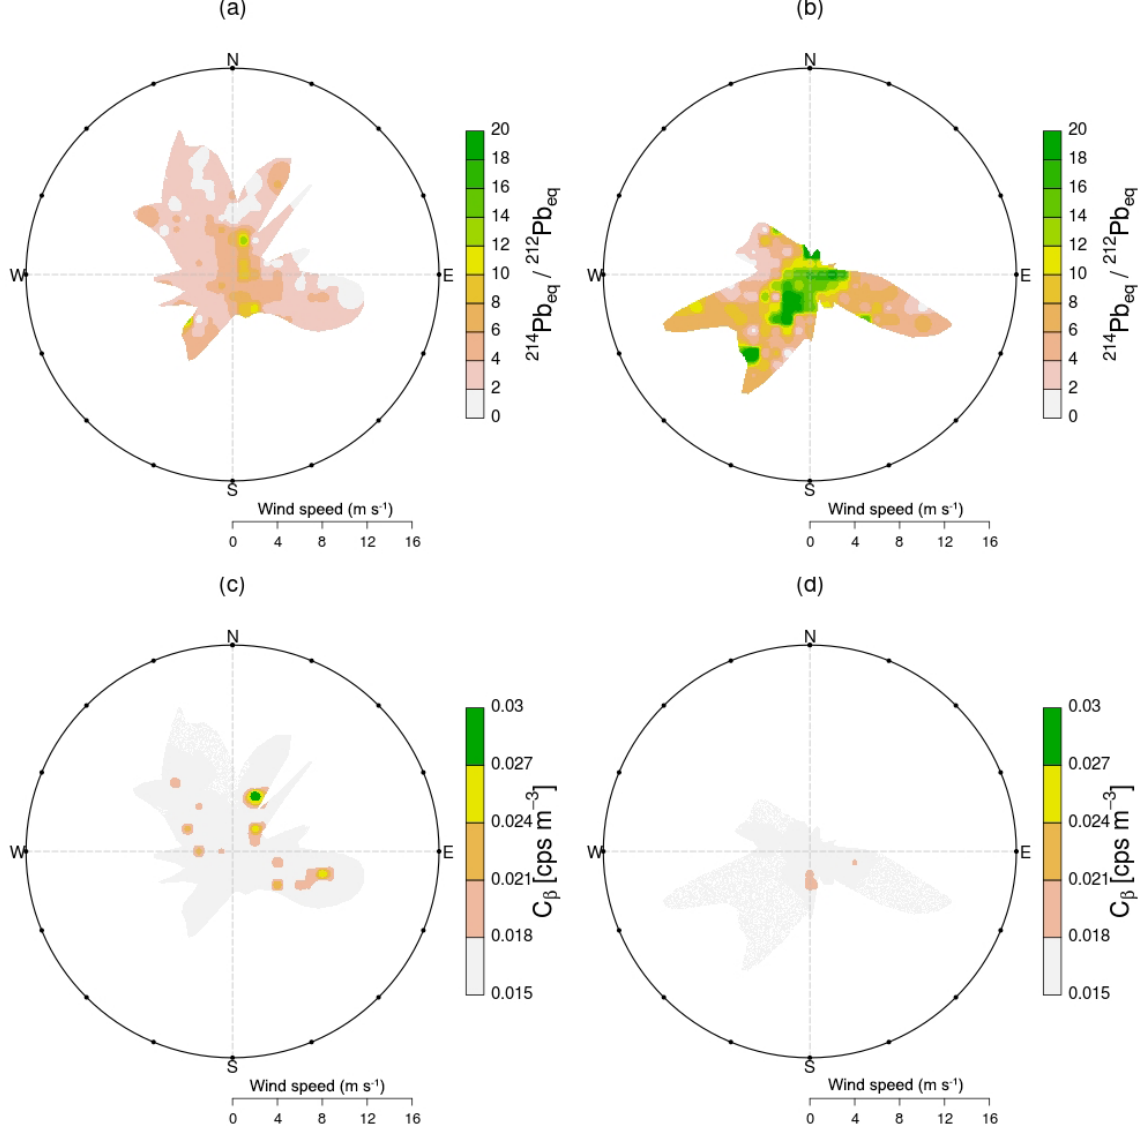
Figure 3. Polar bivariate plots of 214 Pb eq / 212 Pb eq (a, b) and C β (c, d) during the two different emanation periods. The low emanation period (a, c) and the high emanation period (b, d) are based on hourly observations assuming equilibrium between radon